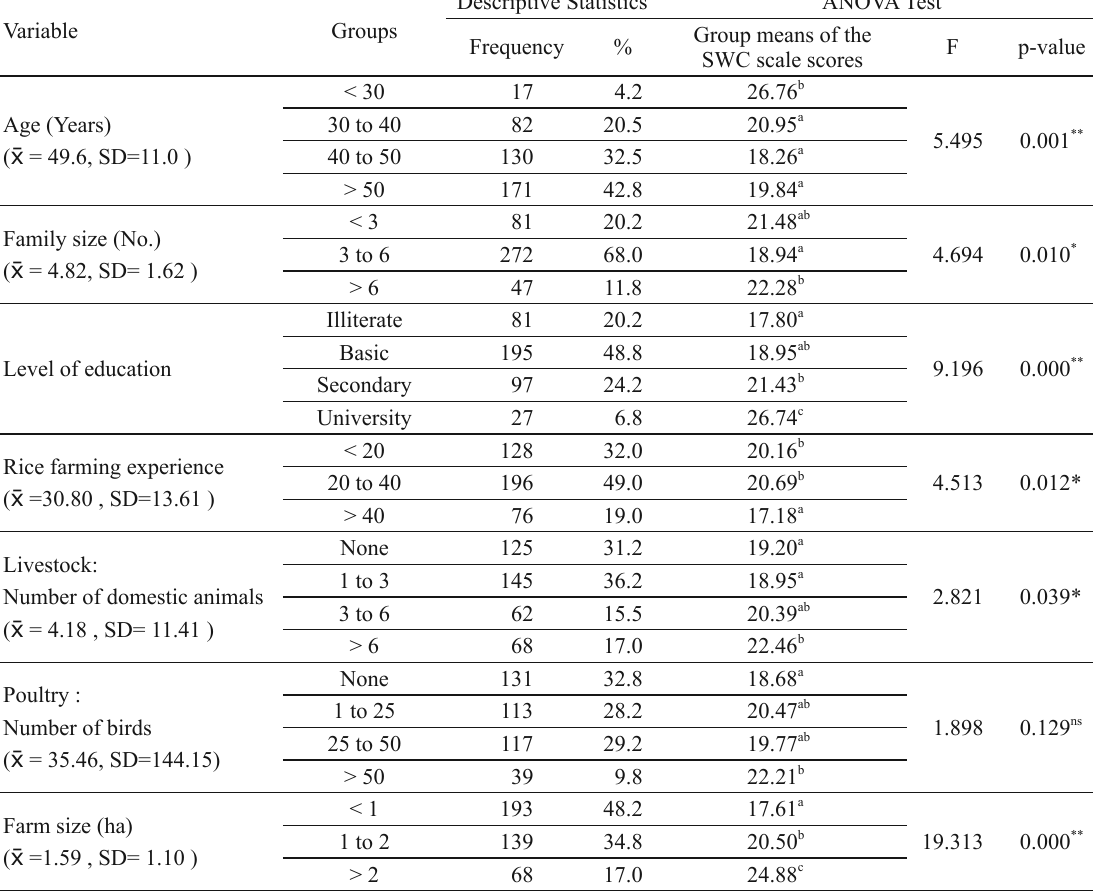
Frequency distribution of socioeconomic characteristics of paddy farmers and Analysis of Variance of the SWC scores by groups of the independent variables (n =